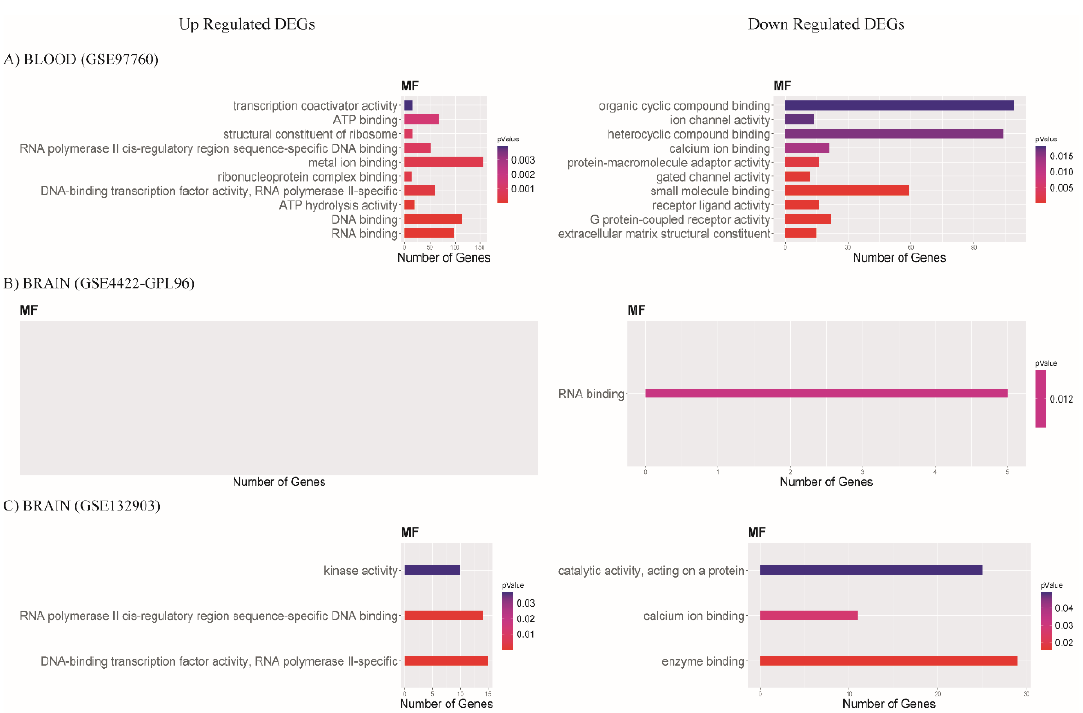
Figure 5. Bar plots show biological process (BP) and most enriched GO terms with p- value < 0.05. Color scale represents p-value; X axis indicates number of genes in each GO term. Data of ( A ) blood GSE97760, ( B ) brain database GSE84422-GPL96, and ( C ) brain database GSE132903.